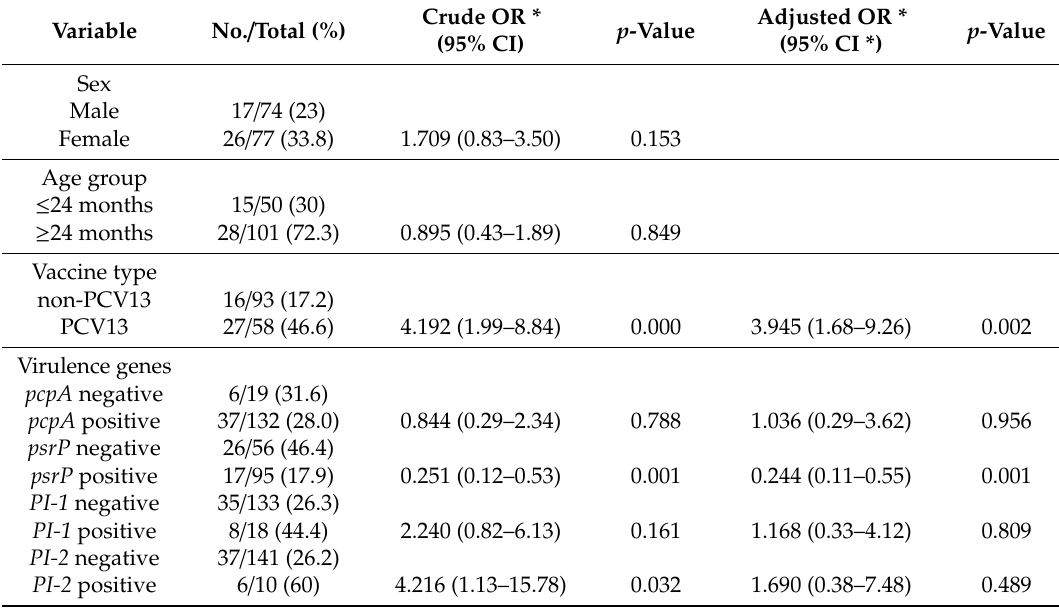
Figure 4. Distribution of multidrug resistance among isolates according to serotype. Pneumococcal isolates resistant to ≥ 3 different classes of antibiotics. Majority of the MDR isolates were PCV13 serotypes, except for serotypes 23B, 15A, 35B and 38. PCV13 serotypes are shown in green color and non-PCV13 serotypes are shown in orange. Table 2. Univariate and multivariate analysis of factors associated with multidrug resistance ( ≥ 3 antibiotics).